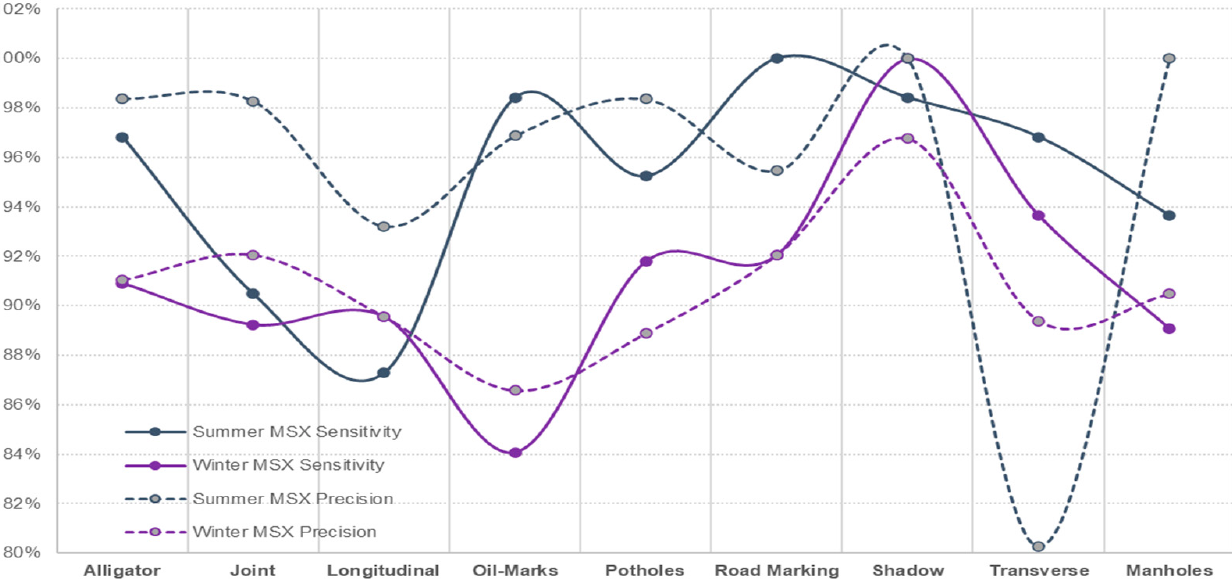
Figure 19. Precision measure. This assessment suggests that IR-T and IR enhanced MSX imaging effectively categorises pavement non-damages at an accuracy level like DC images irrespective of the weather season. Hence, by employing IR technology, images with non-damages can be filtered out from the image processing dataset before applying any filtering method. Thus, reducing the size of dataset requiring further processing in turn benefits from increased processing speed and overall efficiency. Additionally, deep learning techniques applied to images captured during summer sunny conditions exhibit better and more reliable prediction accuracy of over 95% as opposed to winter sunny conditions. Table 6 presents the detailed comparison of the performance of different input data by class.